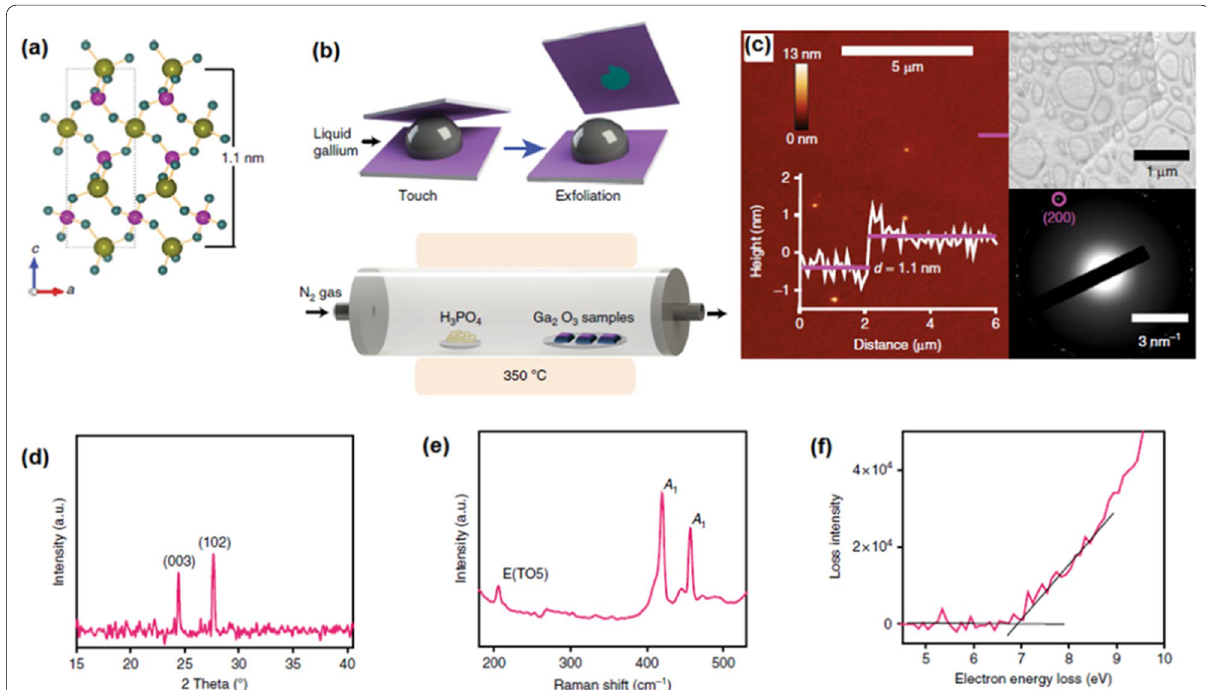
Fig. 11 a The side view of GaPO 4 demonstrating the out-of-plane structure of GaPO 4 . b For the secondary phosphatization treatment. c The AFM and HRTEM studies of 2D